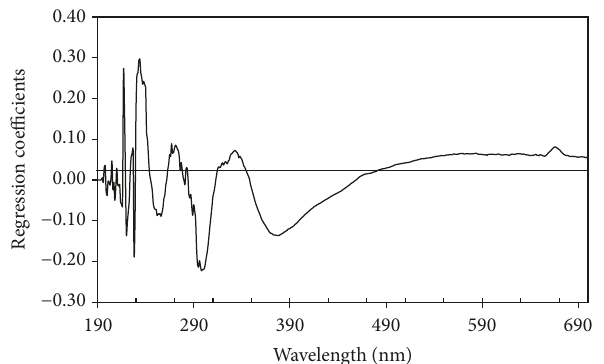
Figure 5: Regression coefficients versus wavelength of coffee sam- ples.